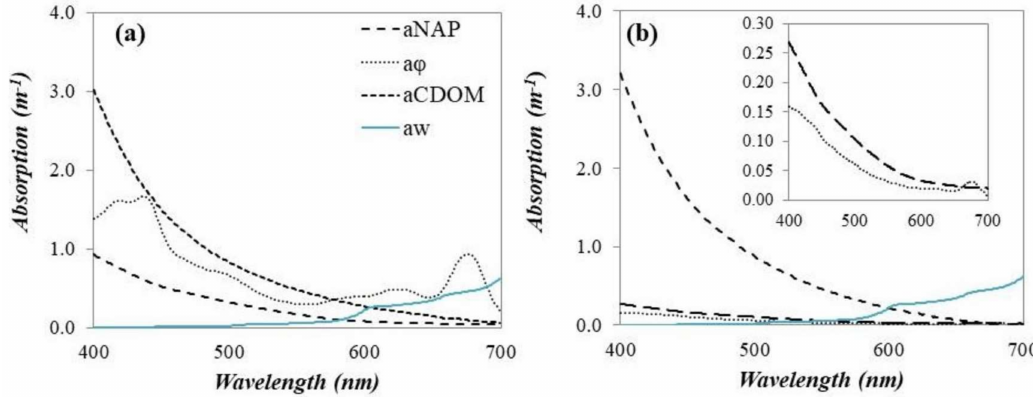
Figure 3. Average absorption spectra of NAP, phytoplankton, CDOM, and pure water (a w ) in BAR1 ( a ) and BAR2 ( b ). ( b ) shows, in detail, the spectral curves of a NAP and a ϕ from 0.0 to 0.30 m − 1 at 400–700